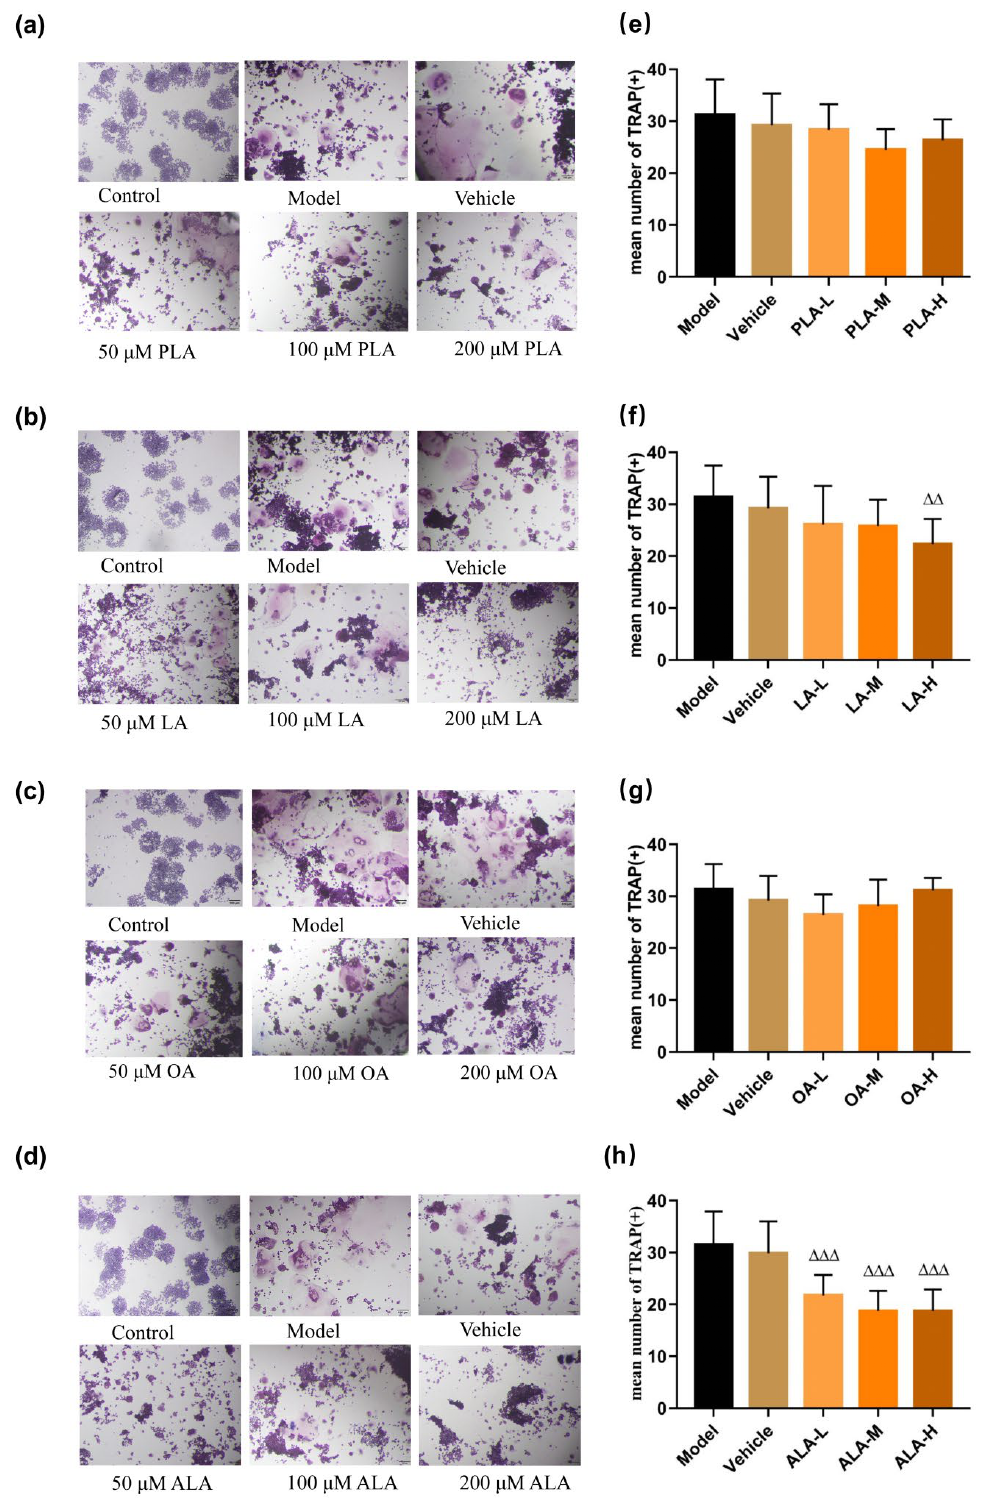
Figure 3. Inhibitory effects of fatty acids on RANKL-induced osteoclastogenesis. ( a – d ) Results of TRAP staining with optical microscope. ( e – h ) TRAP positive cells with >3 nuclei were counted by optical microscope ( × 100). ( a , e ) PLA, ( b , f ) OA, ( c , g ) LA, ( d , h ) ALA, ∆∆ p < 0.01, ∆∆∆ p < 0.001 vs. Model (RANKL